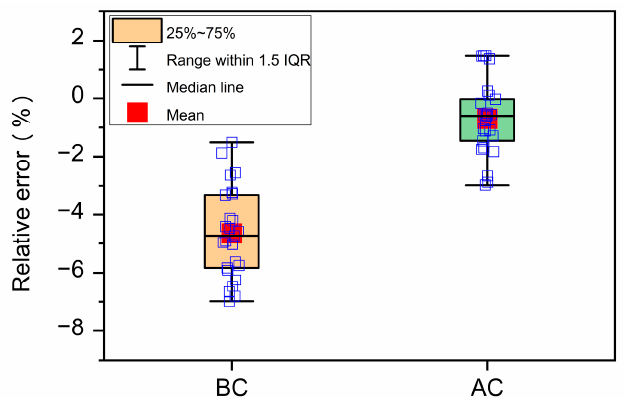
Figure 6. Box plot of the relative error for the measured skin temperature before correction (BC) and after correction (AC).